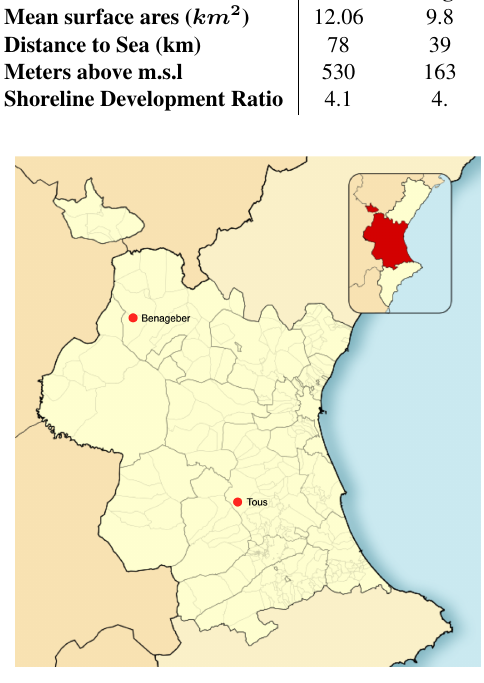
Figure 1. Reservoirs in the province of Valencia,